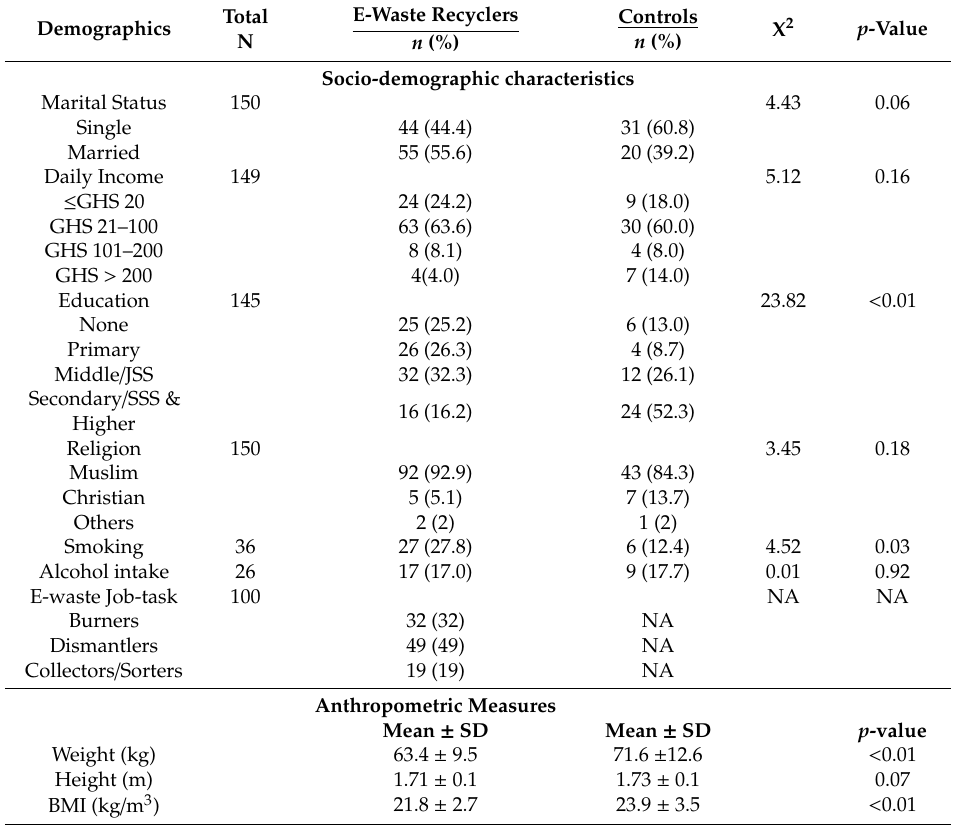
Table 1. Socio-demographic characteristics and anthropometric measures of e-waste recyclers and